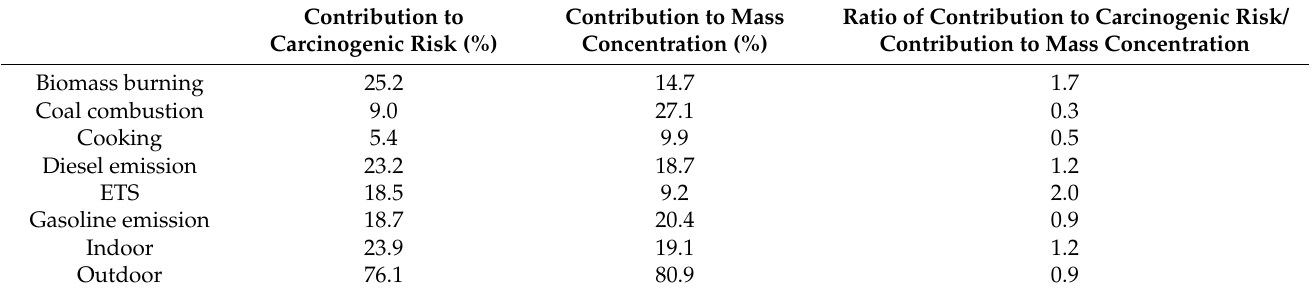
Figure 2. Box (25–75th percentiles) and whisker (5–95th percentiles) plot of inhalational carcinogenic risk of each source (horizontal lines in the middle of the boxes, median values; ETS, environmental tobacco smoking; dotted line, 1.0 × 10 − 6 ). Table 3. Comparison of contribution to mass concentration and carcinogenic risk of each source.